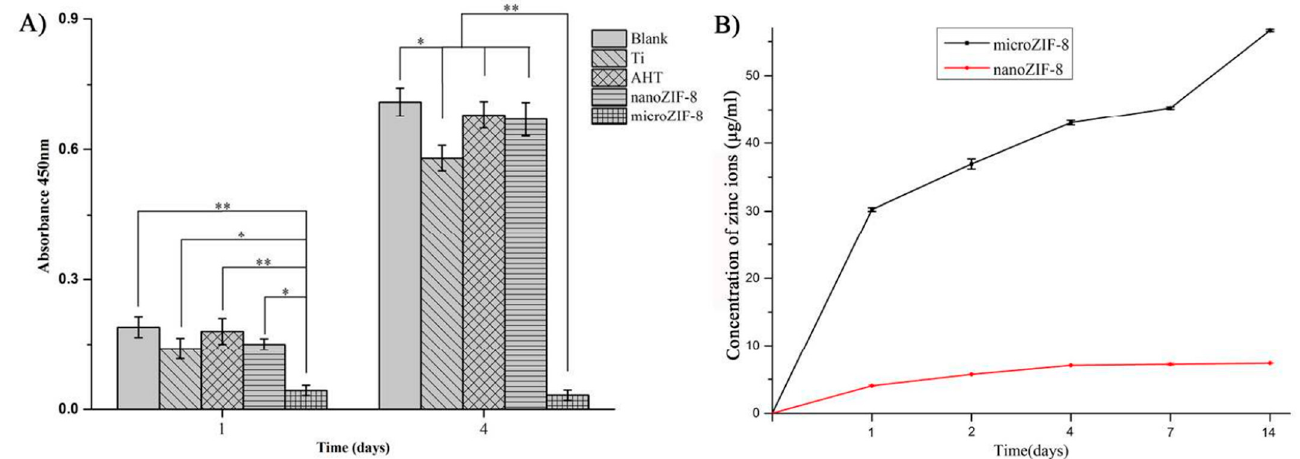
Figure 6. ( A ) Cell proliferation examined with a CCK-8 assay after MG63 cells were cultured for 1 and 4 days. * p < 0.05; ** p < 0.01; ( B ) Biodegradation of nanoZIF-8 and microZIF-8 films in 10% FBScontaining α -MEM. Reproduced with permission from [69].